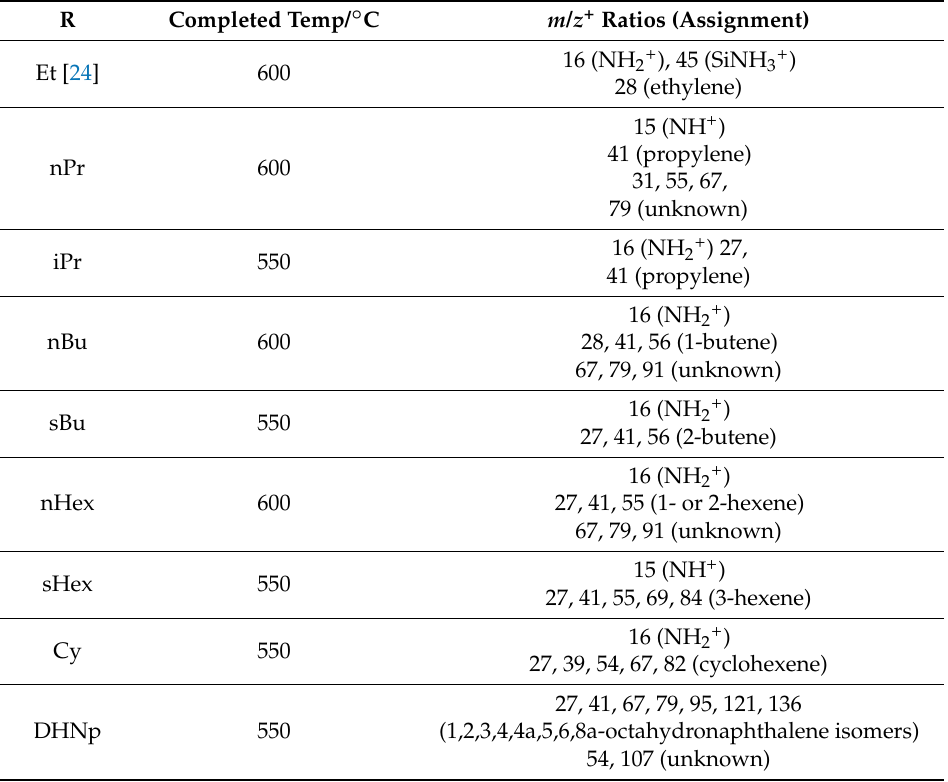
Table 4. Results of in-situ TG-MS analysis during pyrolysis up to 1000 ◦ C under a He